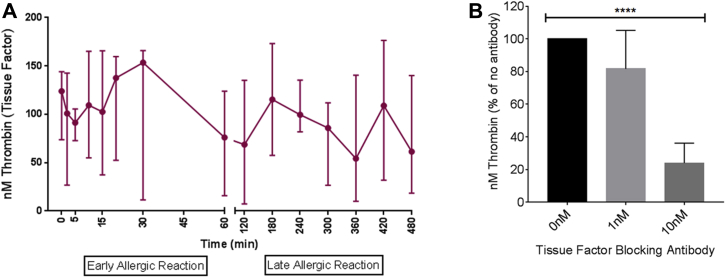
Tissue Factor (TF) is persistently present in the human airway at baseline and during allergen exposure. A, TF levels in the nose were indirectly determined using a TF-dependent thrombin generation assay, carried out at baseline and for 8 hours following NAC (n = 4). Data are represented as the median and interquartile range of the subjects, where the thrombin generation of each sample was determined in 3 independent technical replicates. B, To confirm that thrombin generation was TF dependent, thrombin generation was determined in the presence of an inhibitory anti-TF antibody (1 or 10 nM) (n = 8). The thrombin generation of these 8 samples (20 minutes pre- and post-NAC from 4 donors) was determined as the mean of 2 independent technical replicates. Data are shown as mean ± SEM of percentage change from the 0 nM control in each sample. Inhibition data were tested for significance by 1-way ANOVA (****P < .0001).